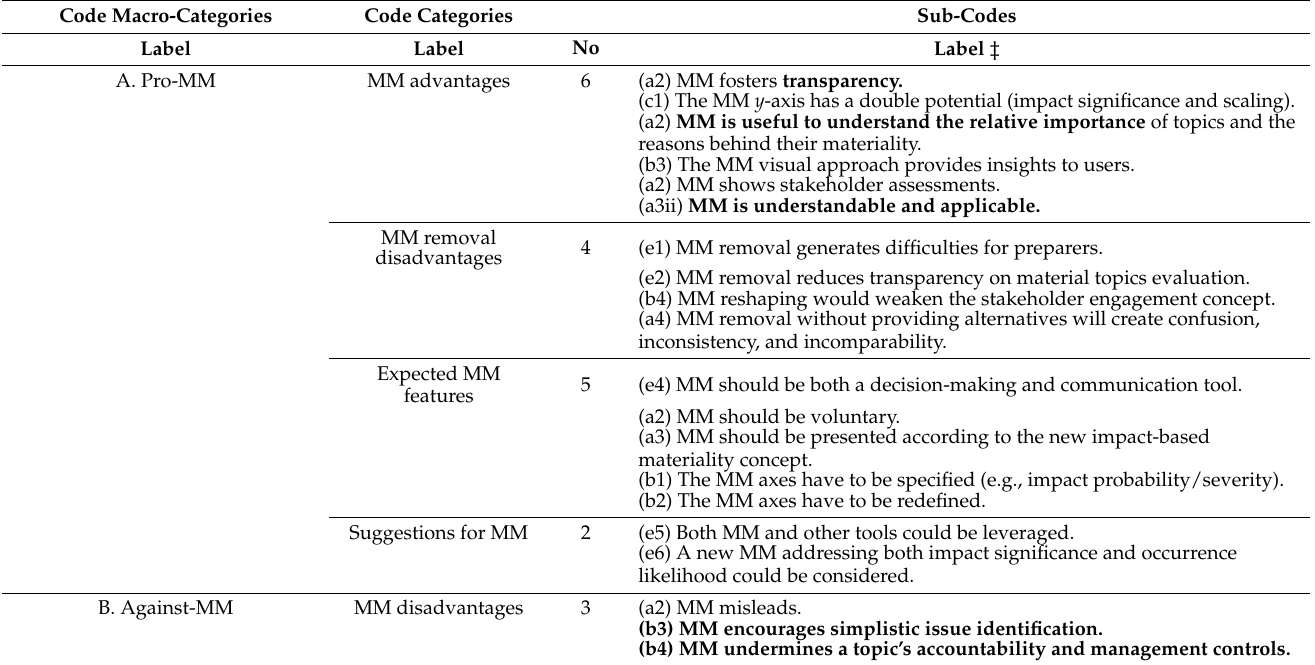
Table 10. Content analysis output: the code